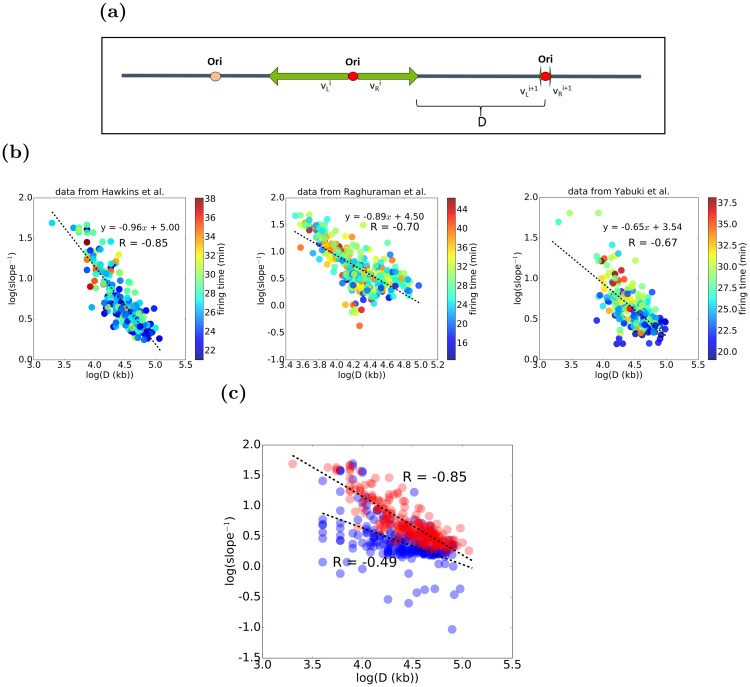
Replication fork speed adjustment based on the distance to the approaching fork.(a) Schematic representation of D, the distance from an emerging fork to an approaching fork. (b) The strong correlation between D and emerging fork speed is observed in three independent data sets [12, 13, 23] (c) dependence of the slope on the inter-origin distance observed in the experimental data (red) cannot be reproduced by our model where forks’ speed varies stochastically but does not depend on the genomic location (blue).